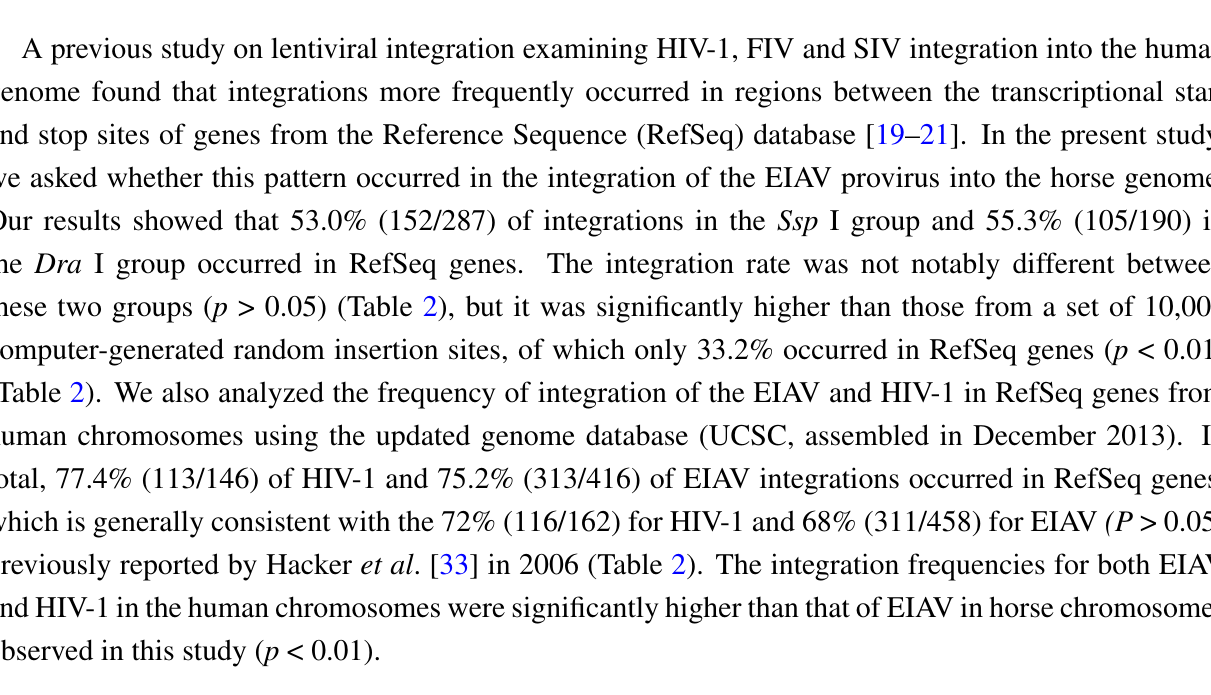
Table 2. Comparison between groups for the integration sites within